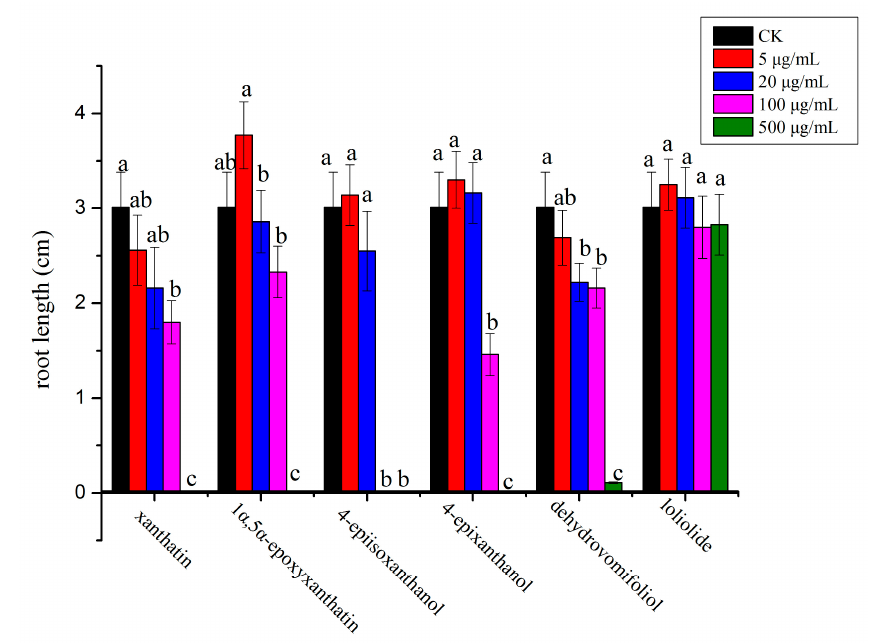
Figure 3. Phytotoxic effect of isolated compounds on root growth of P. annua . Different letters represent a significant difference at p < 0.05 level according to Fisher’s LSD test.